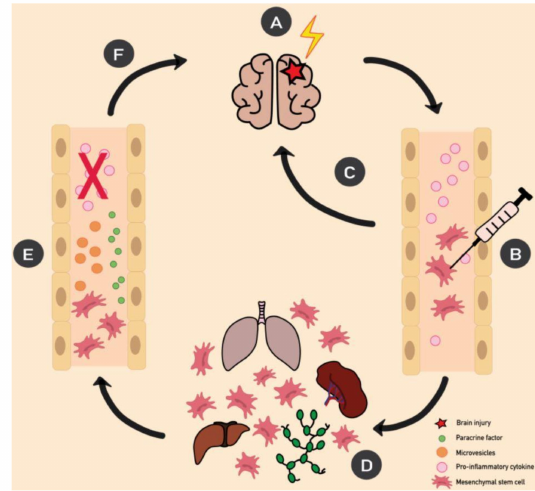
Figure 1. Schematic of the putative mechanisms of action of mesenchymal stem cell (MSC) therapy in neurological diseases. ( A ) Neurological challenges, such as infections, head trauma, and autoimmune diseases, may lead to brain injury, characterized by a release of proinflammatory cytokine. However, even peripheral organ damage may upregulate the levels of proinflammatory cytokines in circulating blood, finally reaching the brain throughout systemic circulation. Once circulating cytokines interact with a neuro-vascular unit, the neuronal excitability threshold is lower and electrical paroxysmal events may happen, leading to a possible alteration of the local neuronal circuitry. ( B ) When MSCs are administered peripherally, ( C ) a smaller part is directly mobilized to the site of injury, while ( D ) most cells get trapped in organs such as the liver, lungs, lymph nodes, and spleen. ( E ) Here, MSCs are activated by inflammatory mediators and release paracrine factors and microvesicles in the